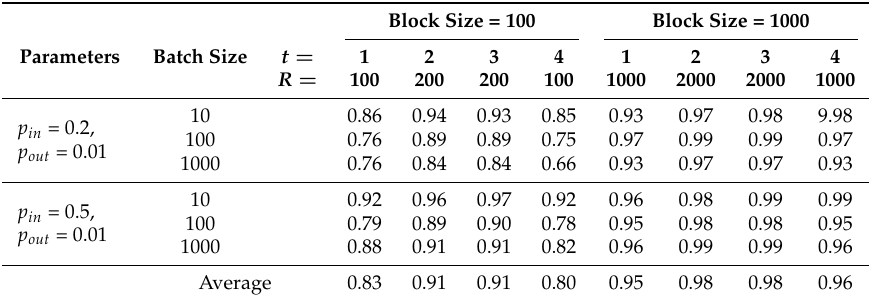
Figure 2. Synthetic dynamic graph showing merging and splitting of communities. ( a ) t = 1, ( b ) t = 2, ( c ) t = 3, ( d ) t = 4. Table 3. Average recalls at each point in time for synthetic merging and splitting of communities over